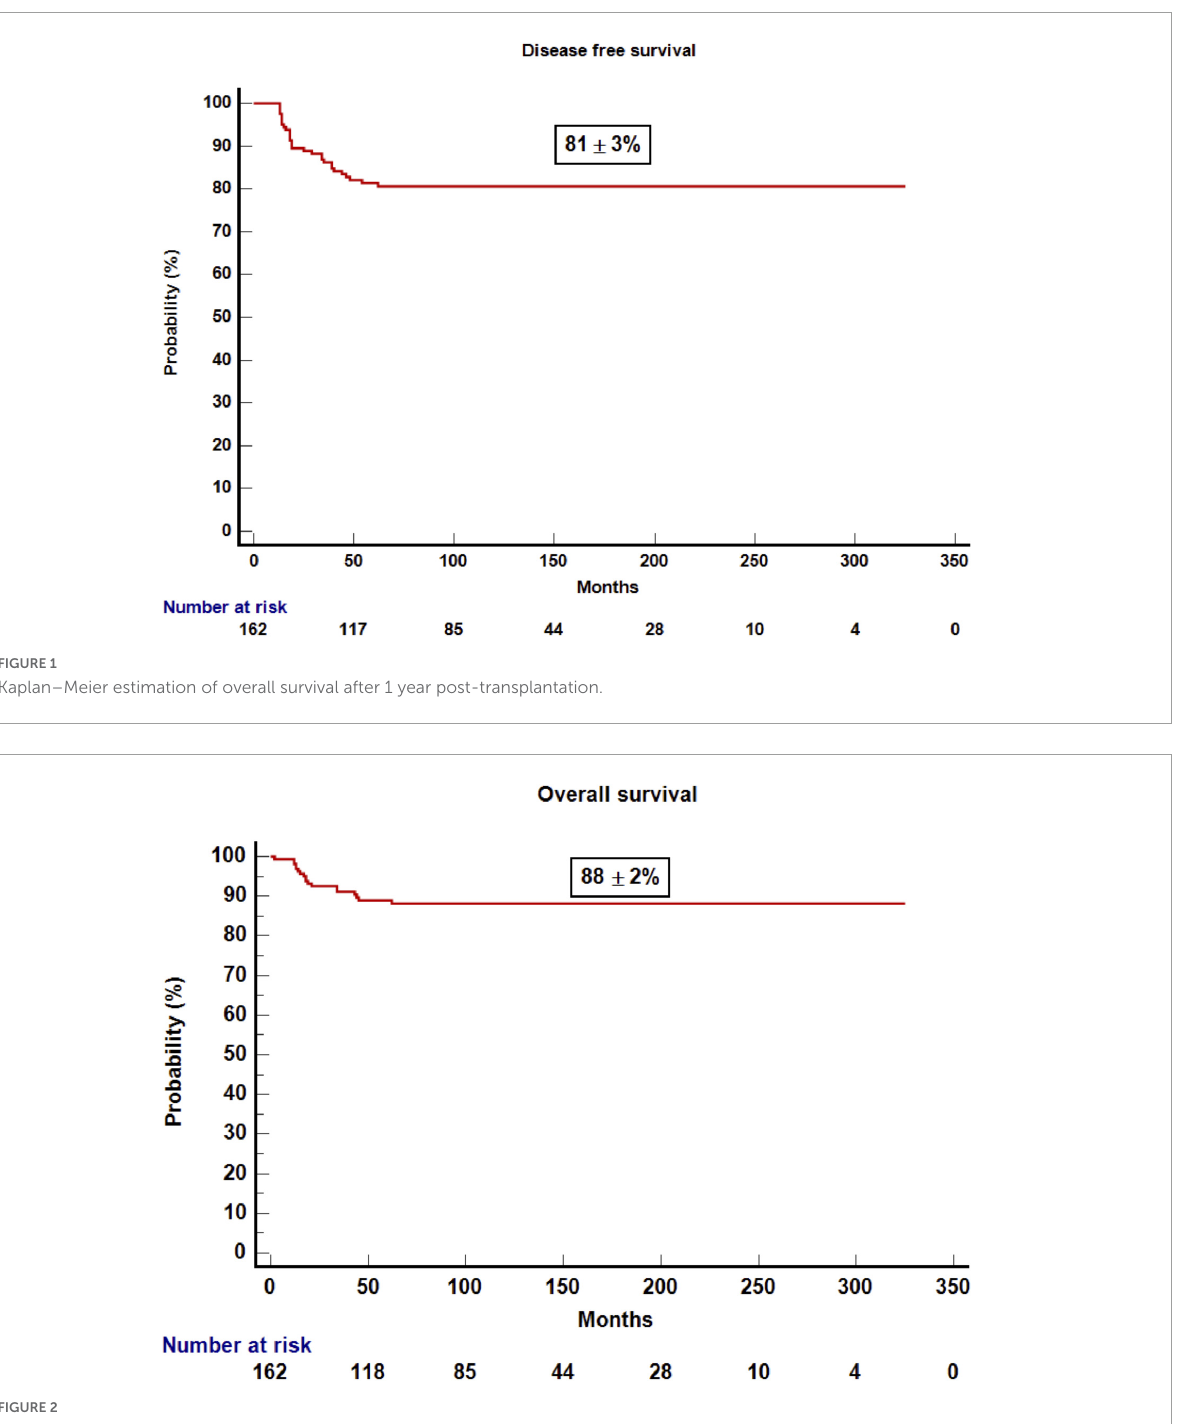
AML, and 0% for those with CML. The cumulative incidence of NRM was 8 ± 2% with a median time to NRM of 18 months (range: 12–62) ( Figure 5 ). NRM was 5 ± 3% for patients with AML, 9 ± 3% for those with ALL, and 14 ± 10% for those